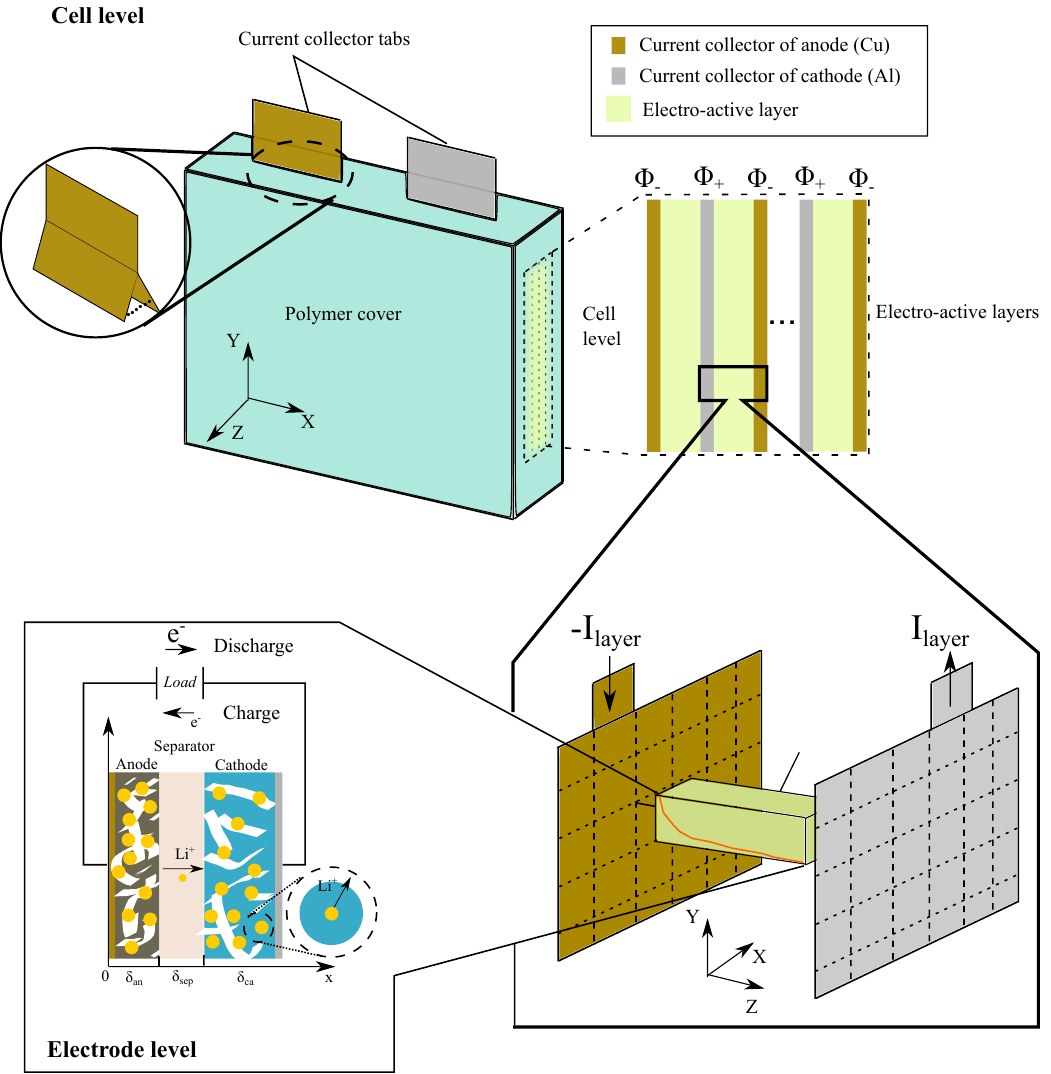
Figure 1. Illustration of the hierarchical framework in 3D multiphysics model of a Lithium-ion pouch cell, including information of cell components, computational domains, and cell